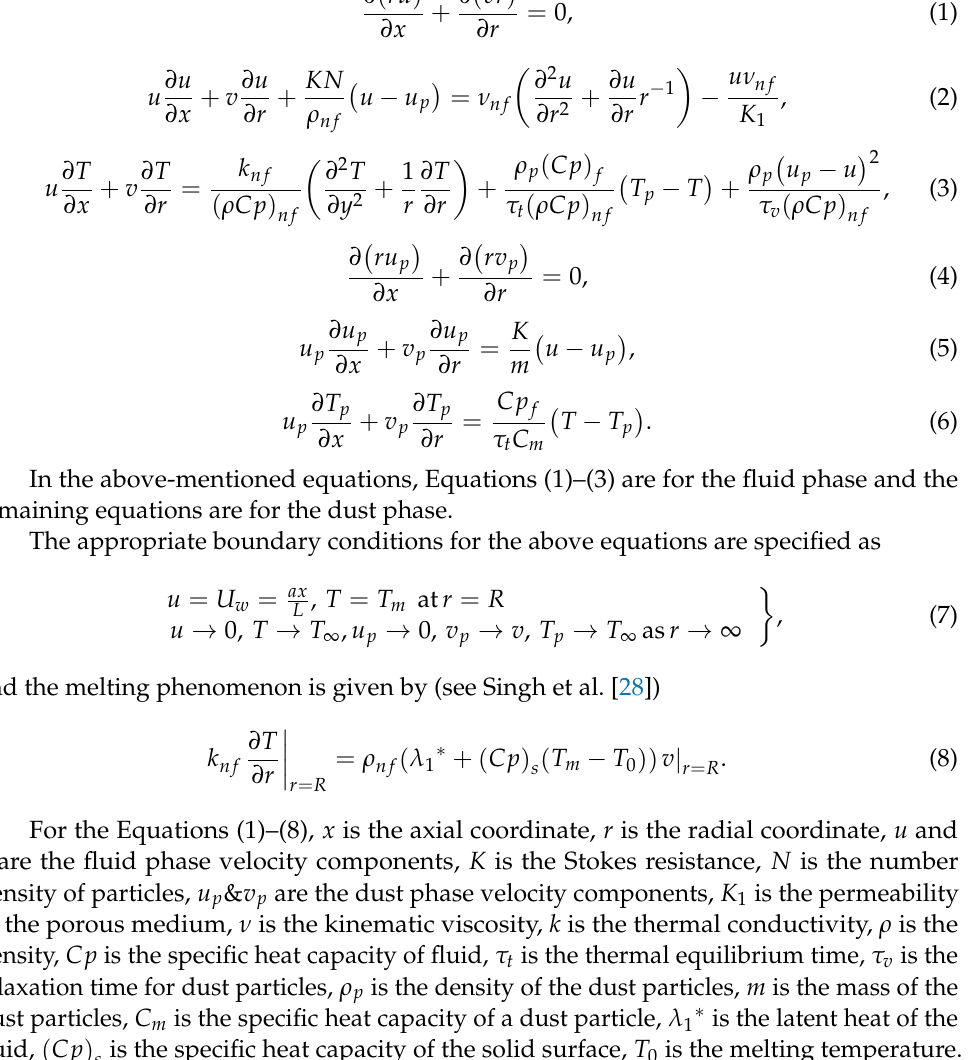
Figure 1. Geometrical illustration of the problem. The following are the governing equations that symbolize the nanofluid phase as well as the dust phase when the porous medium and the melting effect on a stretching cylinder are taken into account (see Manjunatha et al. [26], Waini et al. [27], and Singh et al. [28]).